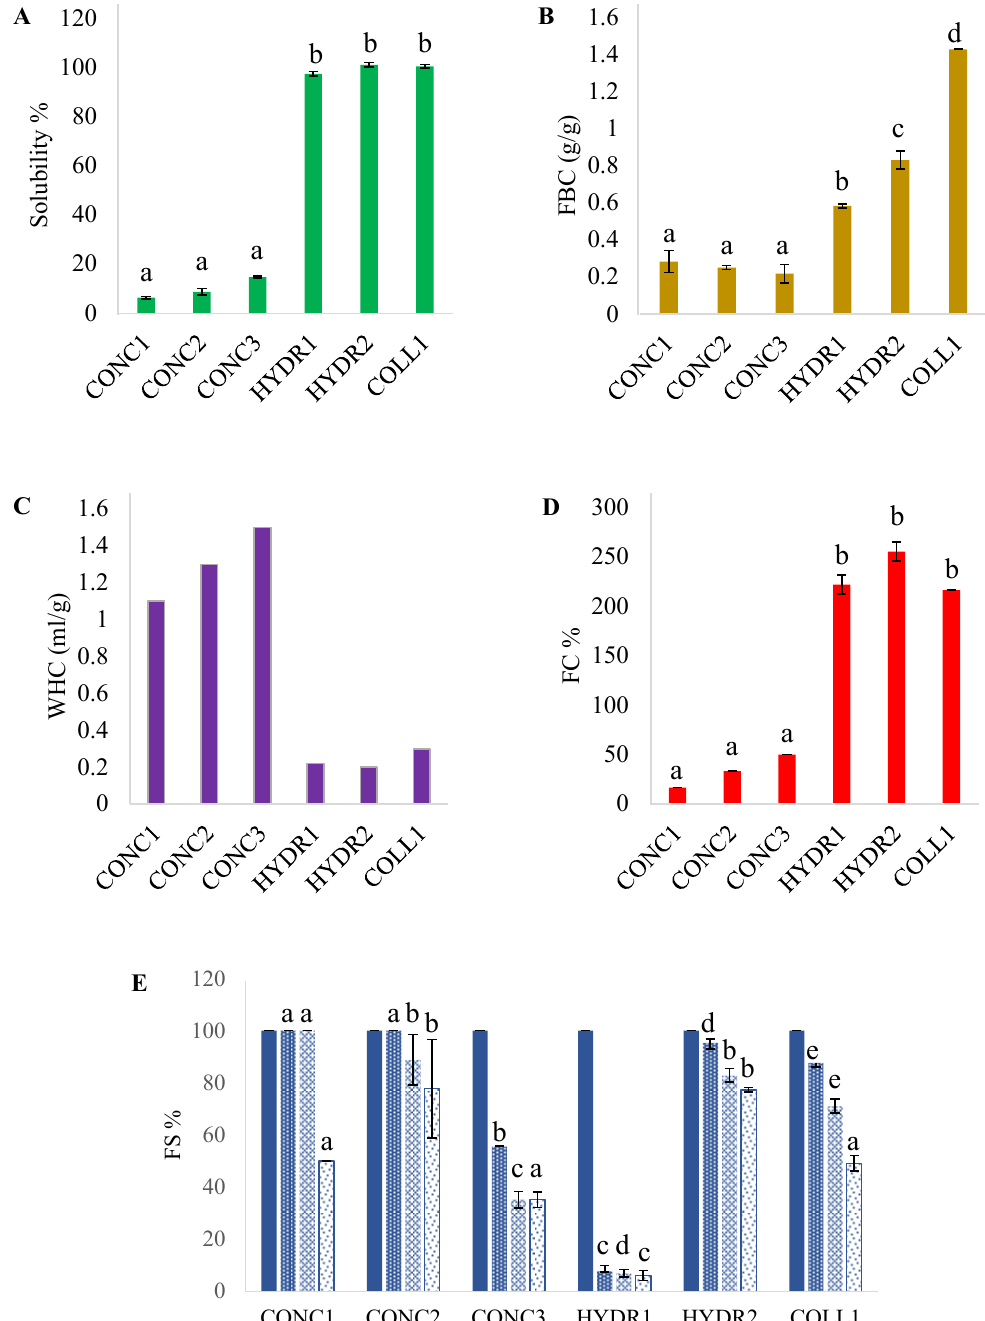
Figure 6. Functional properties of commercial fish protein concentrates, hydrolysates, and hydrolyzed collagen. ( A ) Protein solubility, ( B ) water holding capacity (WHC), ( C ) fat binding capacity (FBC), ( D ) foaming capacity (FC), and ( E ) foaming stability (FS). In figure ( E ), the results are compared by timepoints between the samples. Different letters indicate a statistically significant difference with ANOVA post hoc pair comparison ( p < 0.05). Fish protein concentrates = CONC1–3, fish protein hydrolysates = HYDR1–2, hydrolyzed fish collagen =